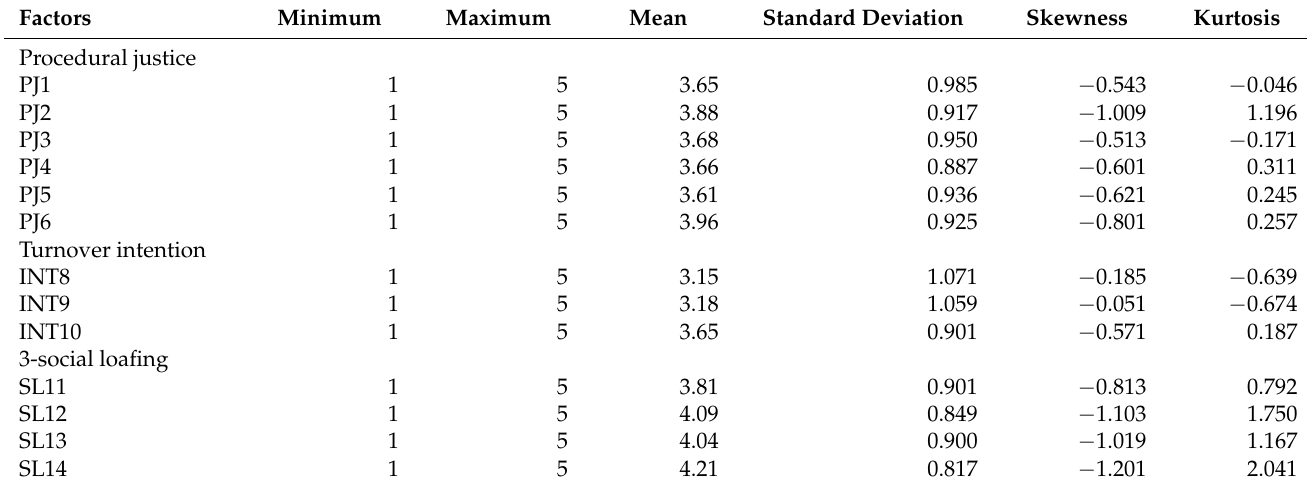
Table 1. Descriptive statistics (developed by the authors based on previous